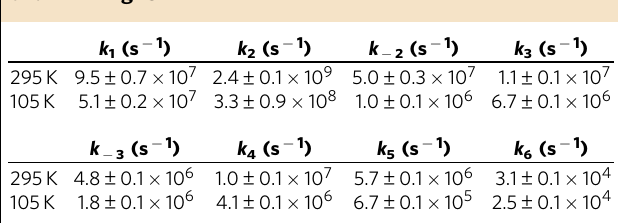
Figure 4 | Transient optical absorption data. ( a ) Species-associated transient absorption difference spectra for NC obtained at 295K in benzonitrile using the kinetic model given in Fig. 3. Inset: single wavelength kinetics and fits to the data. ( b ) Population kinetics for each species. ( c ) Species-associated transient absorption difference spectra for NC obtained at 105K in butyronitrile using the kinetic model given in Fig. 3. Inset: single wavelength kinetics and fits to the data. ( d ) Population kinetics for each species. The total number of T 1 states per S 1 created is twice the population of the T 1 species indicated in b , d . Multiplying the species-associated spectra in a , c by the corresponding species populations in b , d , respectively, yield the complete D A versus time and wavelength data set. Table 1 | Rate constants for NC using the kinetic model shown in Fig.